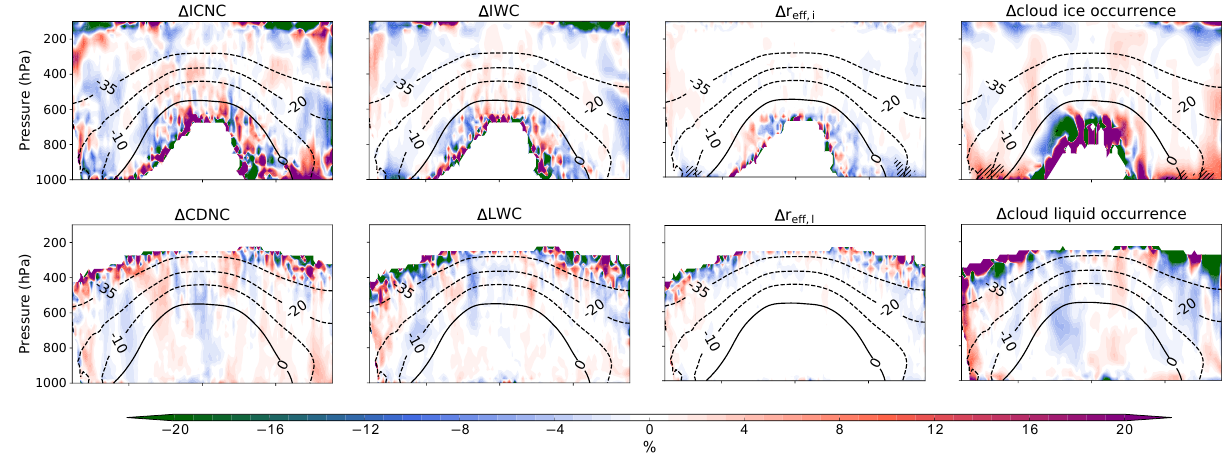
Figure 9. Annual and zonal mean relative change (“MOA” minus “noMOAfrz” divided by the mean of the two) in ice crystal number concentration (ICNC), ice water content (IWC), ice crystal effective radius ( r eff , i ), ice cloud occurrence frequency, cloud droplet number concentration (CDNC), liquid water content (LWC), cloud droplet effective radius ( r eff , l ), and liquid cloud occurrence frequency. All values are in-cloud changes (i.e. during liquid/ice cloud occurrence, respectively). Contour lines are zonal mean temperatures in the mixed-phase range in ◦ C. Hatched areas indicate statistical significance at the 95% level following the Wilks (2016) method for controlling the false discovery rate for data with moderate to strong spatial